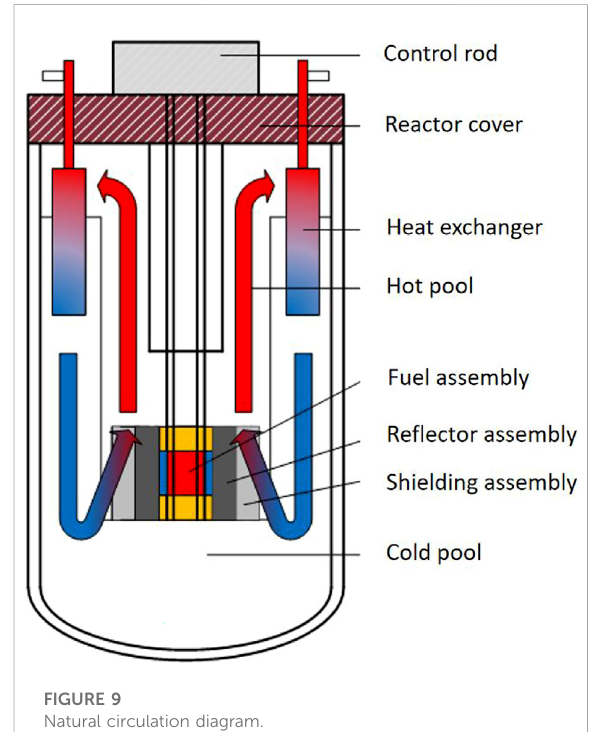
FIGURE 9 Natural circulation